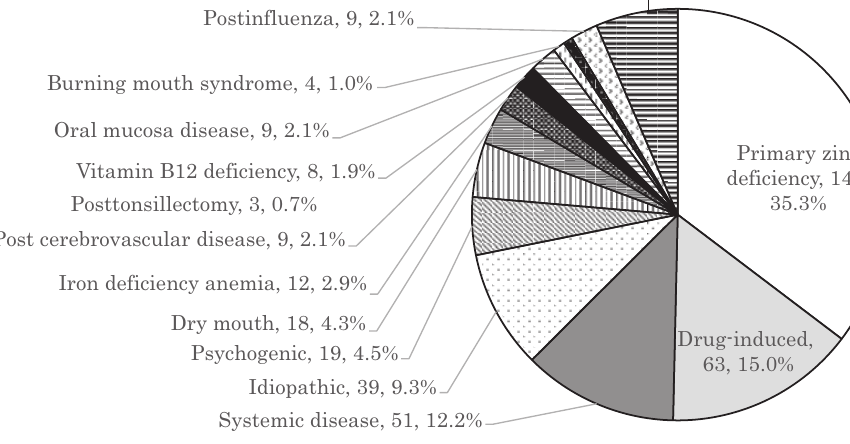
Figure 4. Distribution of causes of taste disorders. The most frequent cause was primary zinc deficiency (n = 148, 35.3%), followed by drug–induced (63, 15.0%), systemic disease (51, 12.2%), idiopathic (39, 9.3%), postcommon cold (27, 6.4%), psy- chogenic (19, 4.5%) and dry mouth (18, 4.3%). The majority of the patients of postcommon cold and postinfluenza had flavor disorders or taste–and–smell